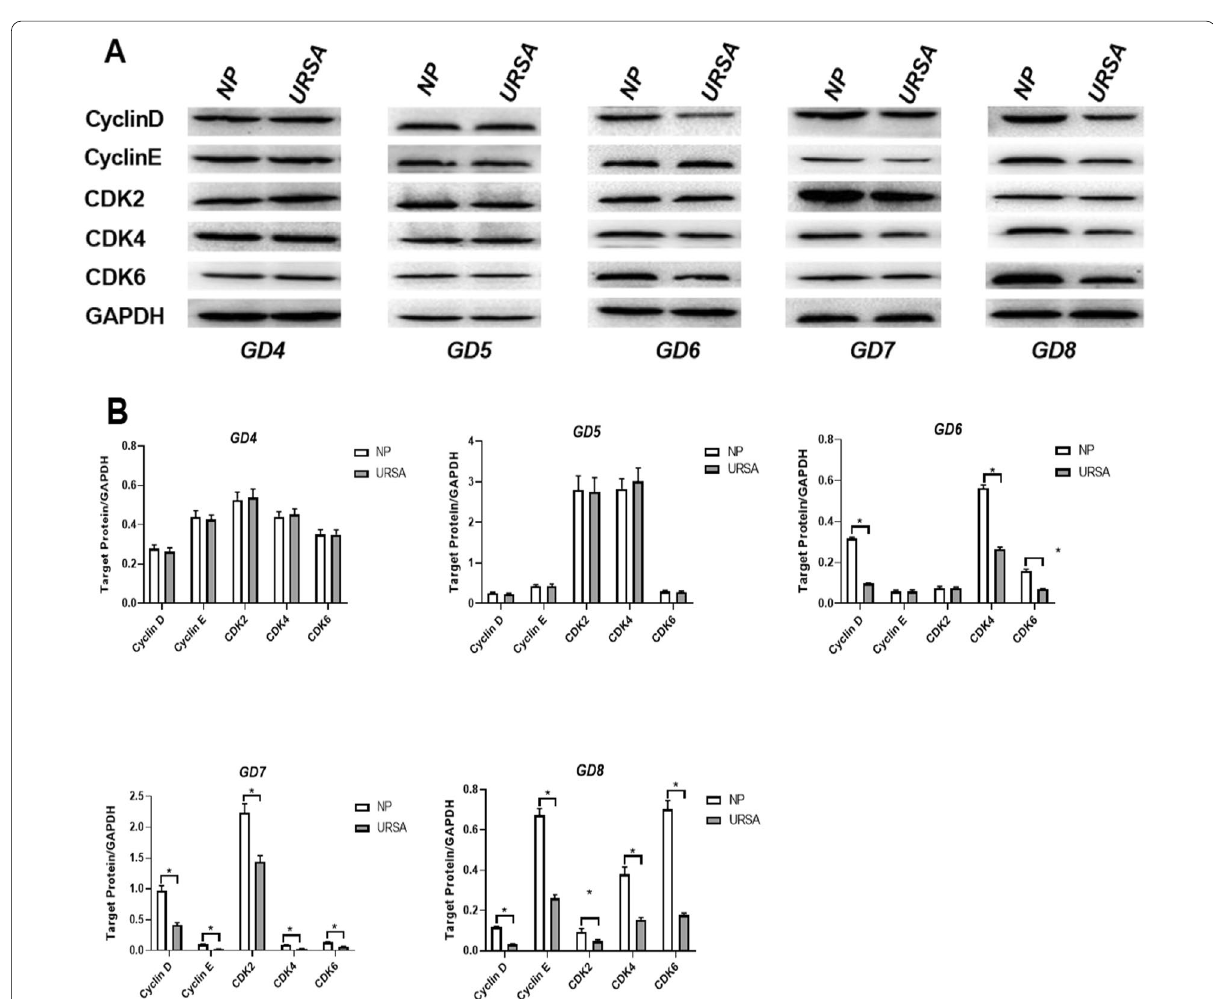
Fig. 4 The indexes gene expression of Cyclin‑CDK in decidual tissues of NP group and URSA groups (mean D, cyclin E, CDK2, CDK4, CDK6 and GAPDH in decidual tissues from GD4 to GD8 between the NP and URSA groups. B Bar graphs showing the quantitative analysis of the protein expression levels of these cytokines based on the Western blot analyses. (n mean SD. *Significantly different (p < ±